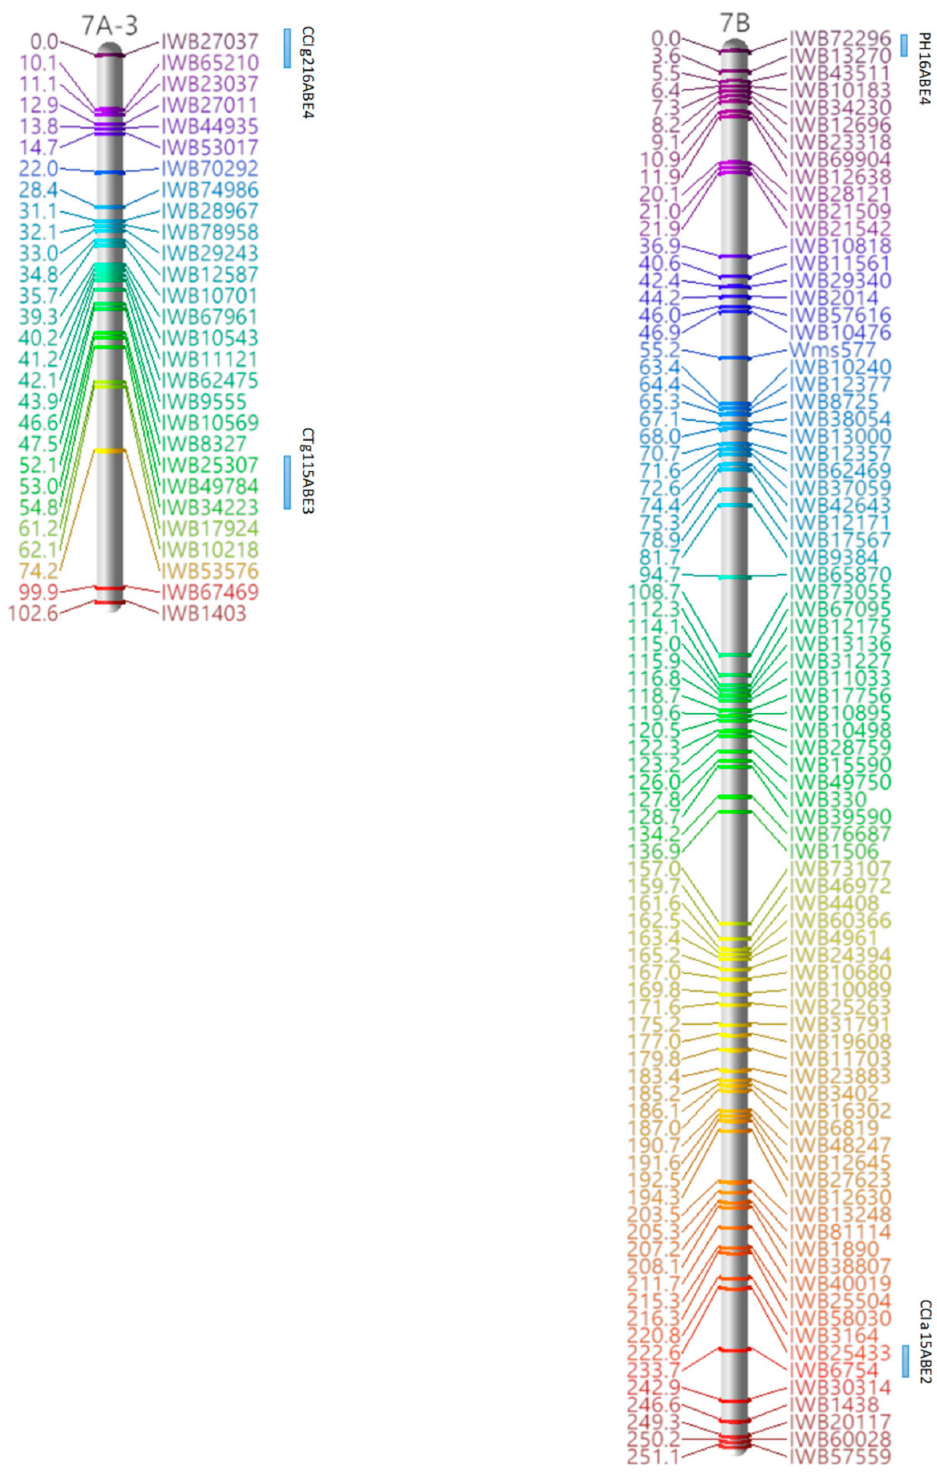
Figure 1. Quantitative trait locus (QTL) for physiological traits (CTa, CTg1, CTg2, CCI a , CCIg1 and CCIg2), PH, TKW and GY on the linkage groups of the doubled haploid (DH) population from UI Platinum/SY Capstone. 15ABE1, 15ABE2, 15ABE3: trial 1, 2 and 3 in Aberdeen in 2015, respectively; 16ABE4, trial 4 in Aberdeenin2016; CTa, CTg1, CTg2, canopytemperatureduringanthesis, mid-grain-fillingandlategrain-filling stage, respectively; CCIa, CCIg1, CCIg2, chlorophyll content index during anthesis, mid-grain-filling and late grain-filling stage, respectively; PH, plant height; TKW, thousand kernels weight; GY, grain